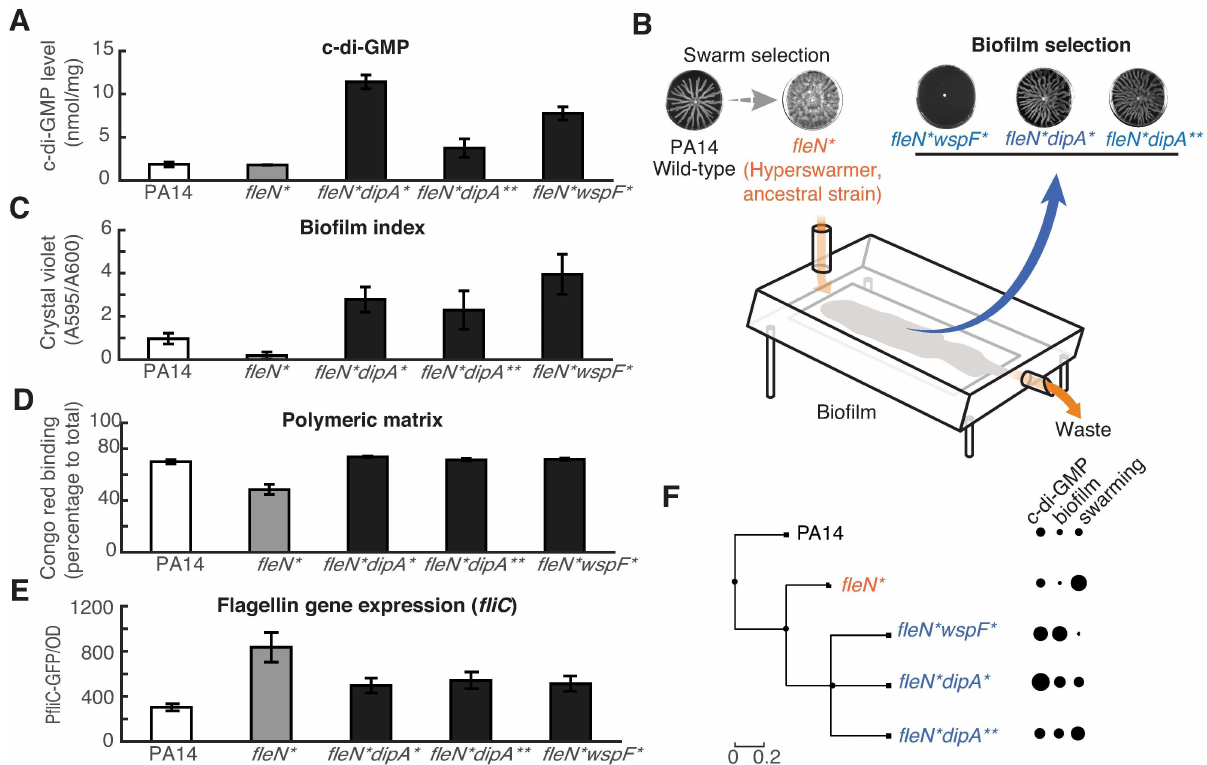
Fig 4. Specialist strains produced by strong selection in laboratory evolution have large-effectalleles in c-di-GMP network. A: Bulk c-di-GMP levels measuredfor evolved mutants, collectedfrom bacterial colonies. B: Diagramof drip flow biofilm reactor used in biofilm selection.C: Biofilm levels quantifiedby the crystal violet assay. D: Productionof extracellularpolymers requiredfor biofilm formation, measuredusing the Congo-red assay. E: Expression of the gene fliC requiredfor flagellasynthesis, measured as GFP expressedby the reporter fusion P fliC -GFP. The data of three evolvedmutants fleN * dipA * , fleN * dipA ** and fleN * wspF * in B-E are statistically different from ancestralstrain fleN * (P < 0.05). F: Phylogeneticrepresentation of the mutants evolved in laboratoryexperiments showingthe tradeoff betweenbiofilm and